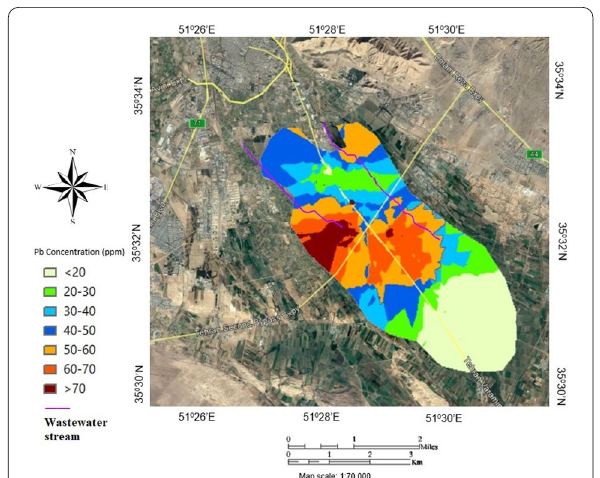
Fig. 2 Distribution heavy metal lead in south